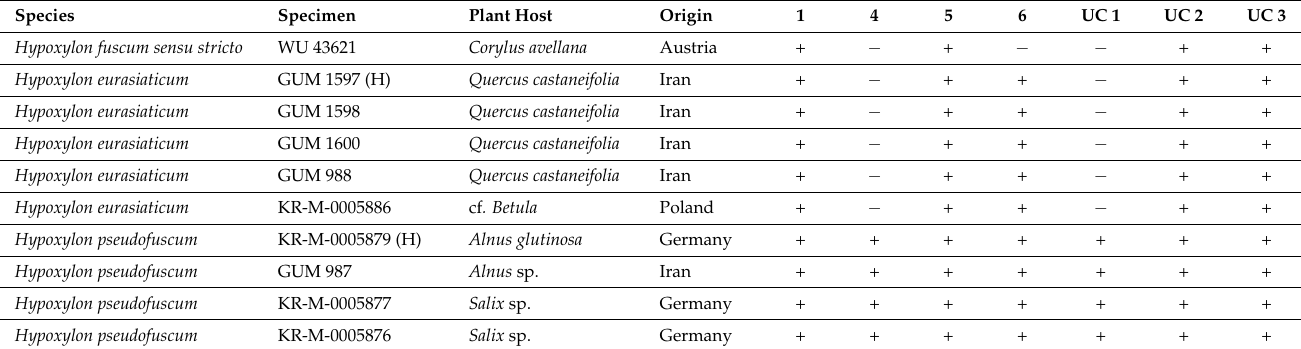
Table 3. Summary of chemotaxonomic results on selected specimens. 1 : BNT; 4 : Pseudofuscochalasin A; 5: Daldinin F 6